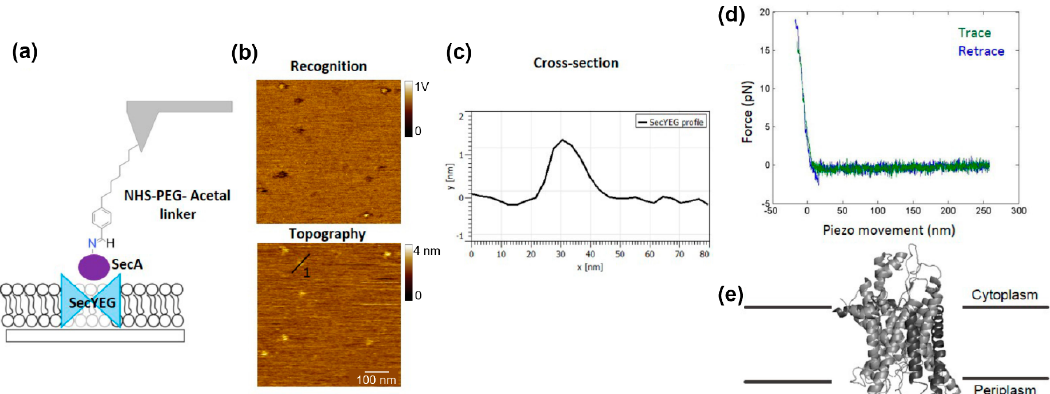
Figure 4. Proof of concept: characterization of the SecA–SecYEG interaction. ( a ) Scheme of SecYEG complexes reconstituted into a planar lipid bilayer with the tip carrying a SecA molecule attached via an N-hydroxysuccinimide (NHS)–PEG–Acetal linker. ( b ) SecYEG molecules that interacted with the SecA on the tip appear as dark spots in the recognition images. ( c ) Cross-section of SecYEG. ( d ) Characteristic force-distance curve for the SecYEG–SecA interaction. ( e ) Side view of the crystal structure of SecYEG from M. Jannaschii (PDB-ID 1RHZ).